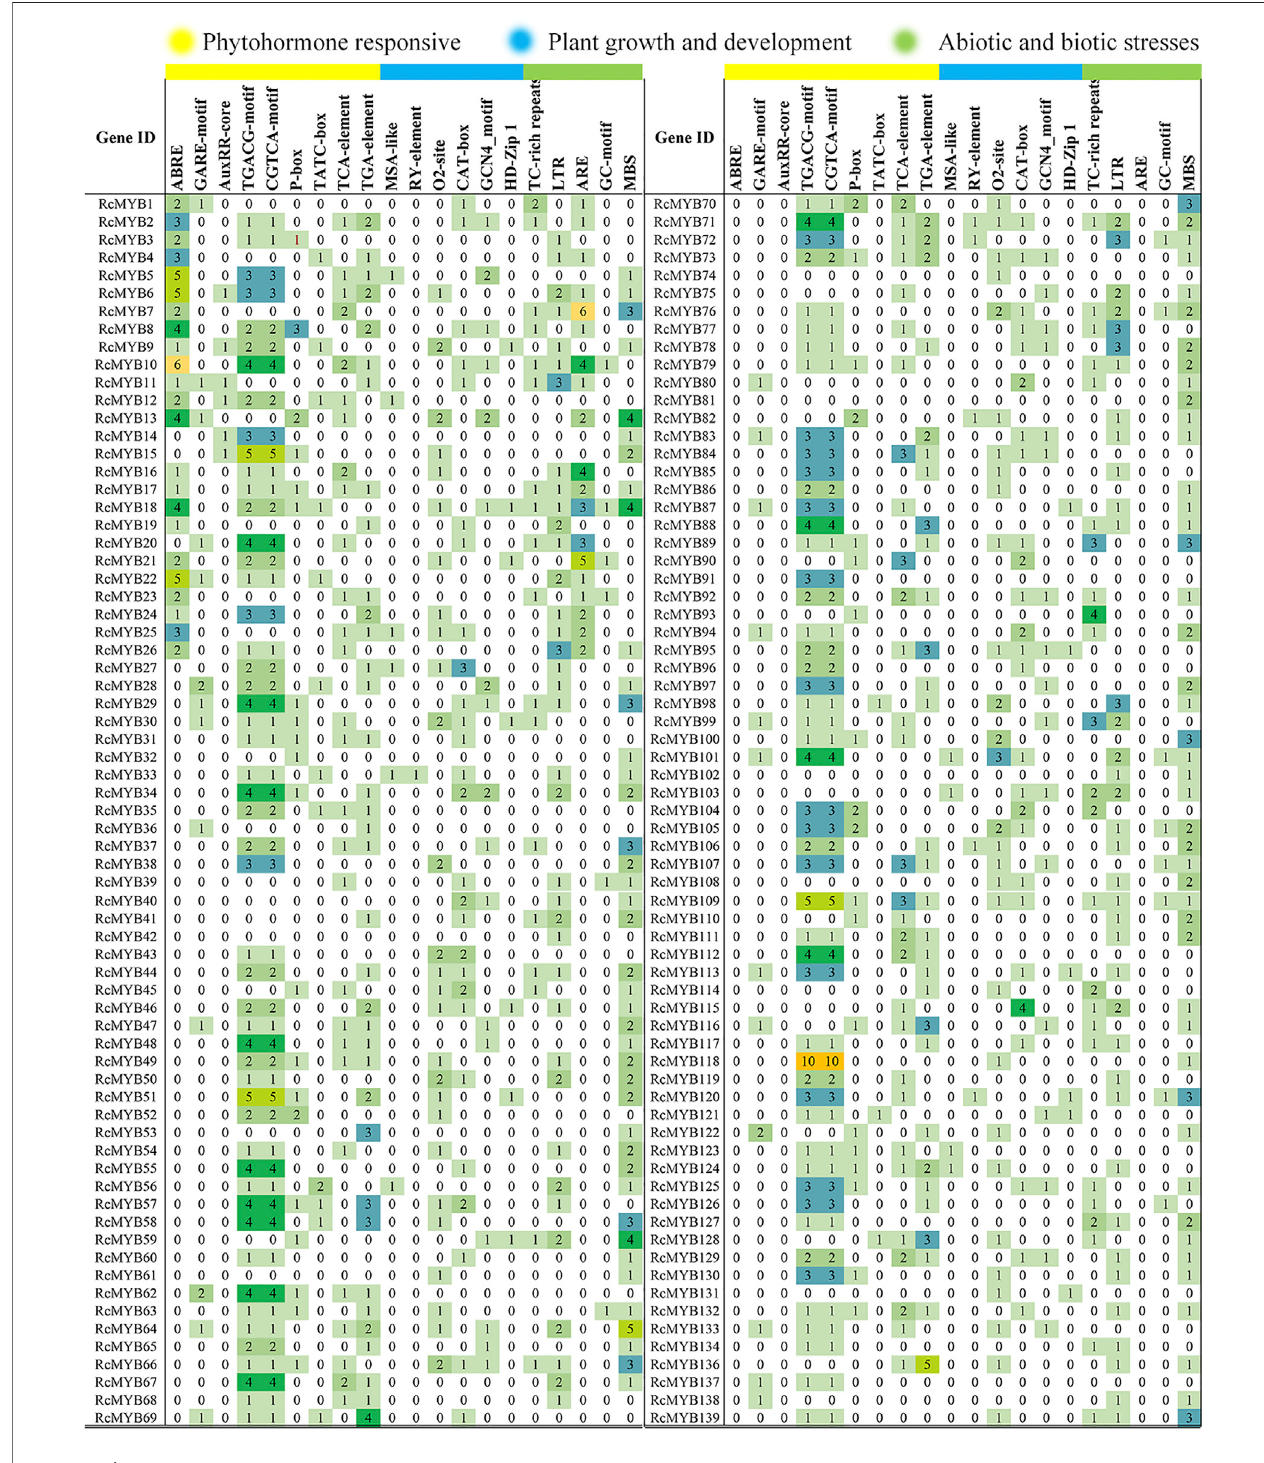
Frontiers in Genetics |